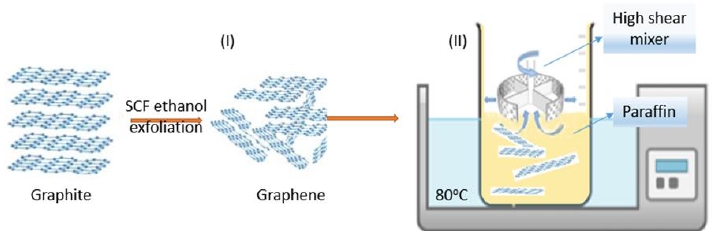
Figure 1. Multilayer graphene – paraffin composite preparation steps: ( I ) multilayer graphene was prepared by supercritical fluid exfoliation in ethanol aqueous solution and ( II ) multilayer graphene dispersion in paraffin matrix by high-shear mixer at 80 °C and 5000 rpm for 30 min.